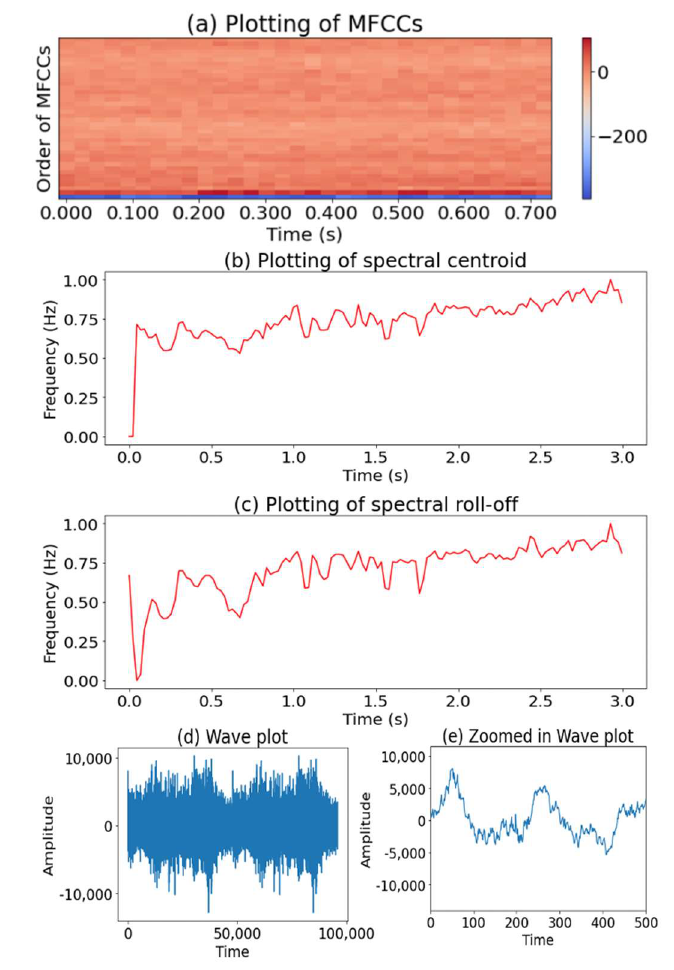
Figure 10. Graphic representation of acoustic features extracted from the sound of a moving